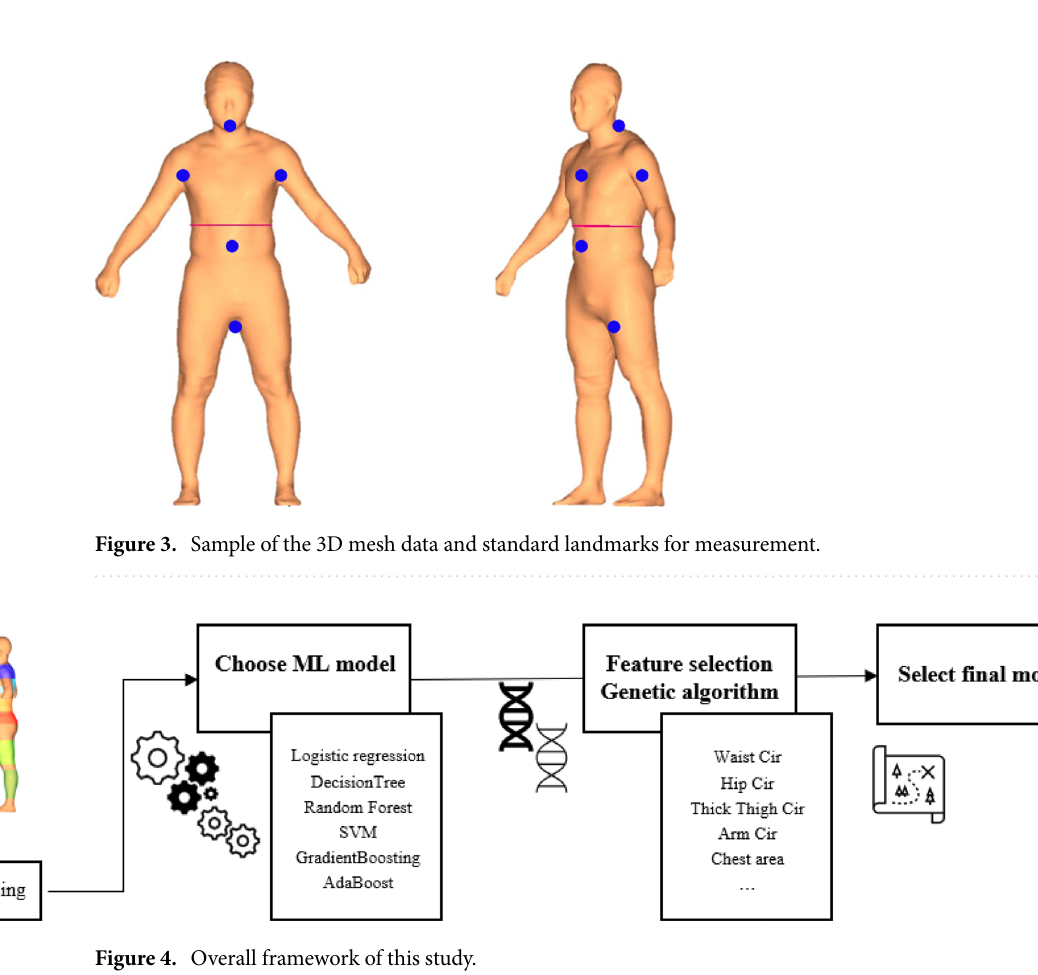
Figure 4. Overall framework of this